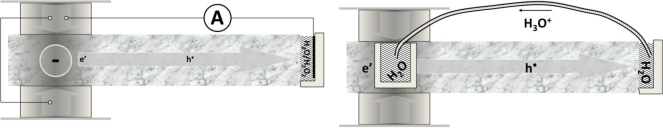
Experimental set-up to demonstrate the accelerated dissolution (electrocorrosion) of the rock surface while h• charge carriers flow into the water reservoir for which circuit closure has been established.